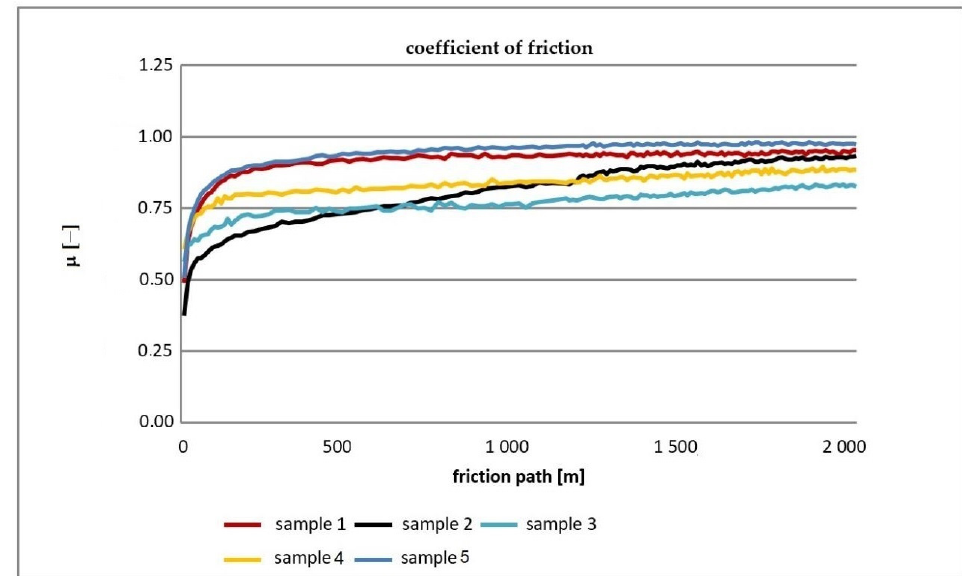
Figure 4. Change of the coefficient of friction for all samples.